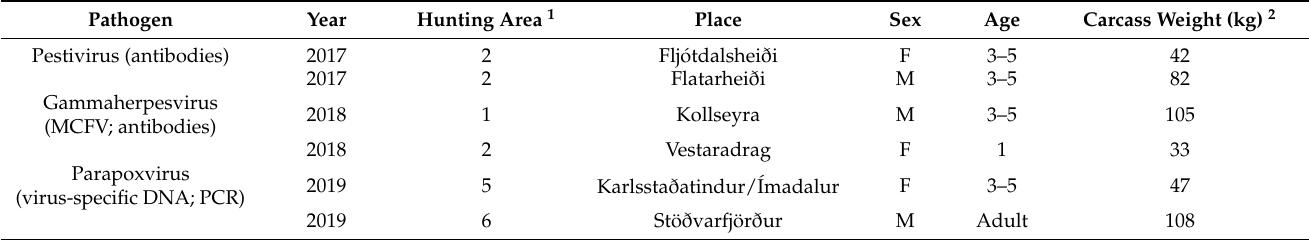
Table 4. A summary of sero-positive and PCR-positive reindeer indicating the investigated